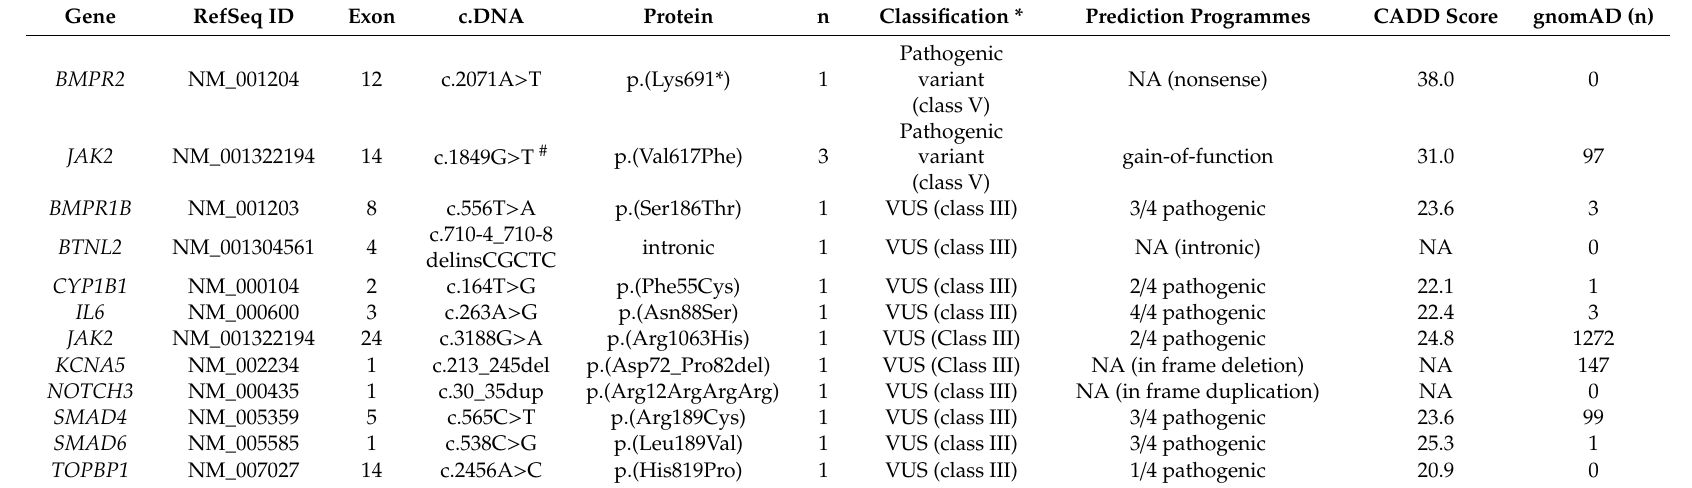
Table 2. Genetic variants class III-V in CTEPH patients identified by next generation sequencing